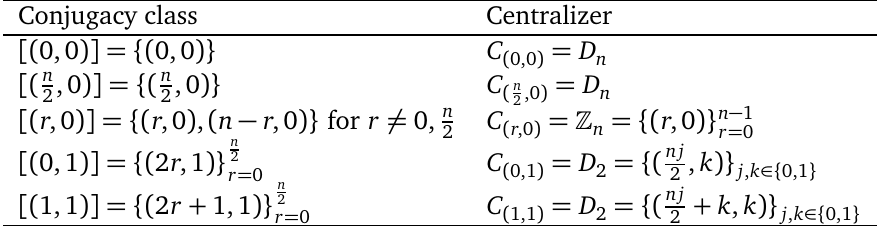
for even n and their centralizers. n